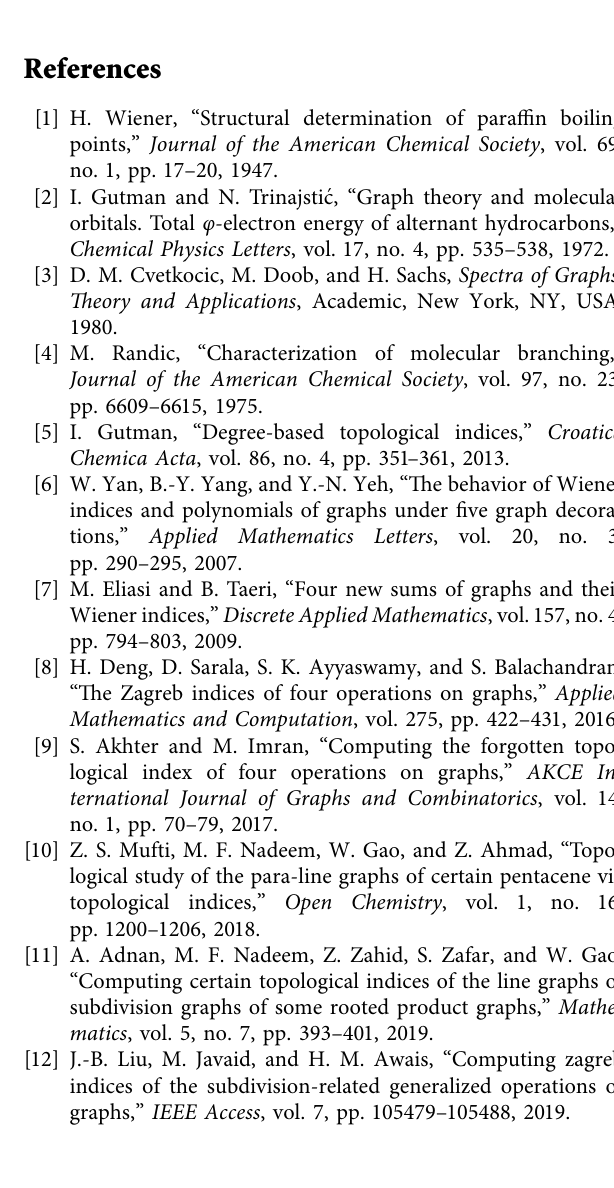
( P [ P ] ) , where k ∈ 1 , 2 , 3 , 4 { } n m R k 2